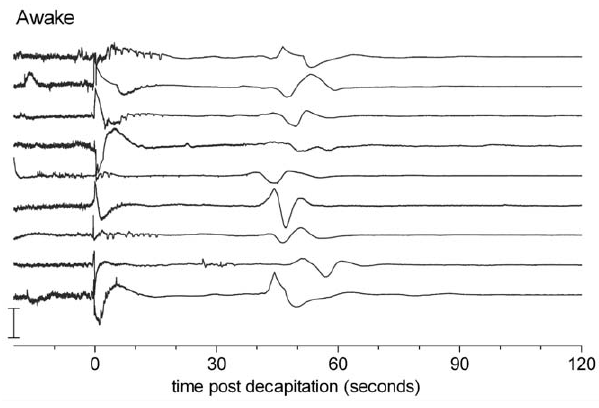
Figure 1. EEGs recorded in 9 animals after decapitation. Note the large slow wave around 50 s after decapitation. Similar experiments were performed in an anesthetized group of animals, where the wave appeared at a slightly later instant, approximately 80 s. The changes in amplitude at t=0 are movement artifacts due to the decapitation. Figure from